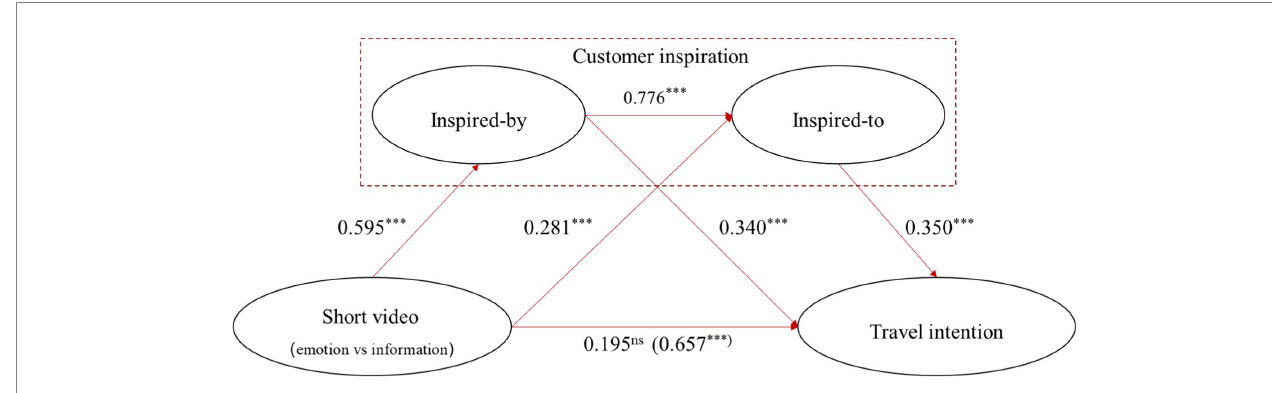
FIGURE 2 The continuous mediation effects of inspired-by and inspired-to customer inspirations in the effect of short videos on travel intentions. ***Represents a significant level of